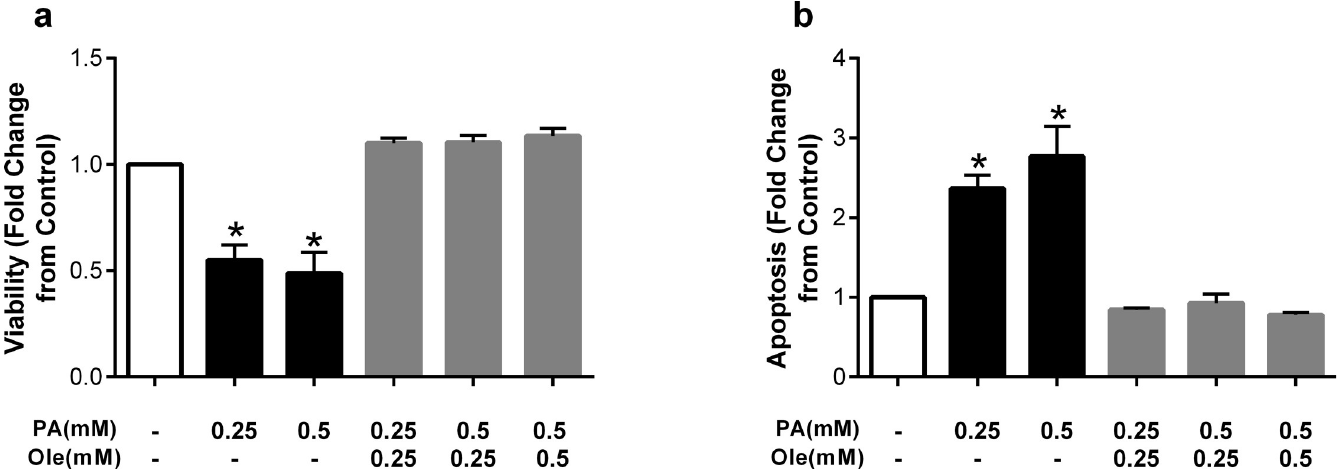
Fig 2. The monounsaturated fatty acid oleate prevents detrimental effects of palmitate. Fold change from control in a) viability and b) apoptosis after treatment with palmitate (PA) at 0.25 or 0.5mM, or co-treatment with the unsaturated fatty acid oleate (Ole). Data are expressed as mean ± SEM; n = 4–5 independent experiments; � p < 0.05 vs control.